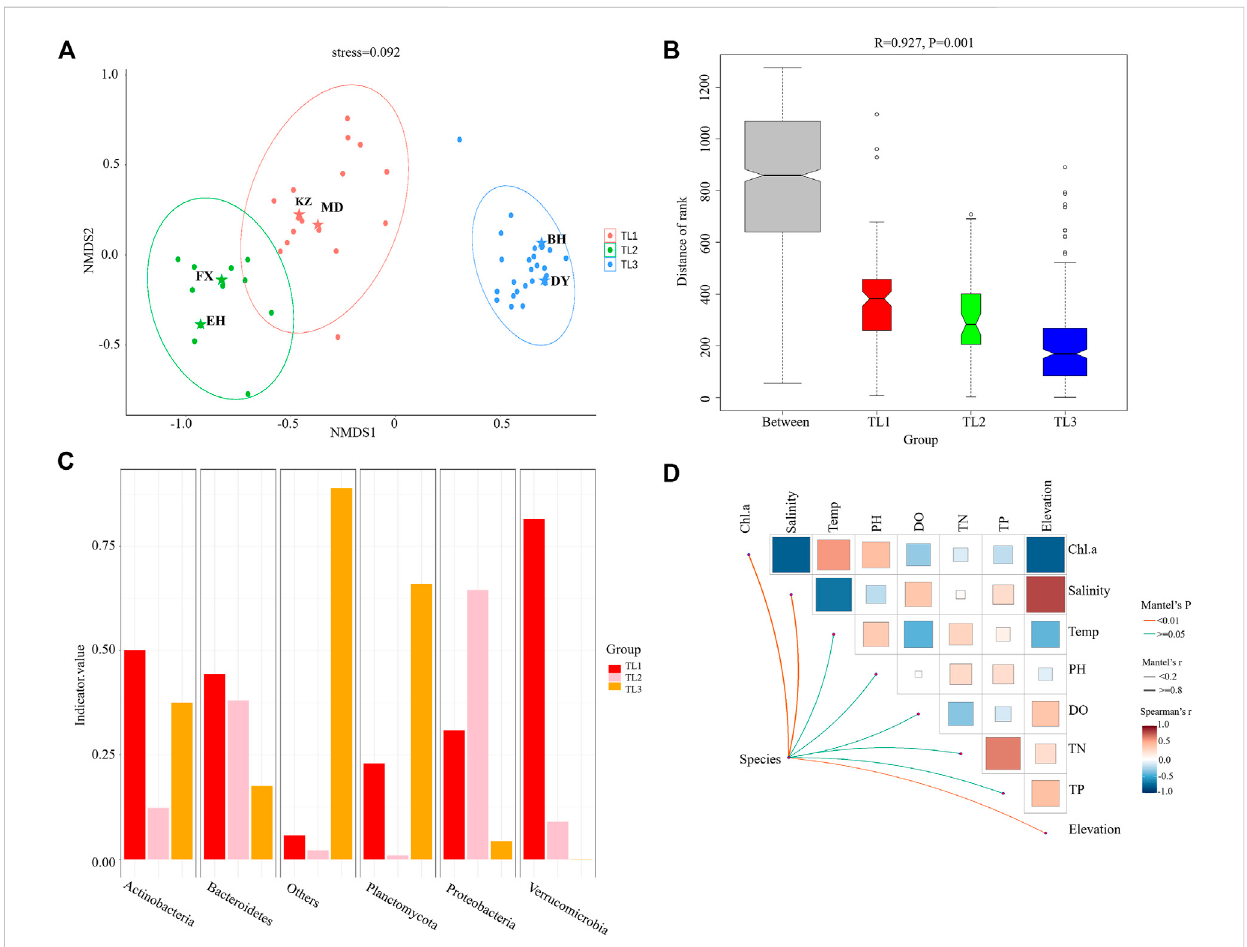
FIGURE 2 Microbial community diversity and its correlation with environmental drivers in surface water samples from 51 lakes. (A) Results of NMDS analysis of microbial composition based on Bray-Curtis similarities. The fi ve-pointed star site represents six typical lakes selected for sampling (Mandong Co (MD), Kunzhong Co (KZ), Erhai (EH), Fuxian Lake (FX), Bohu Lake (BH) and Daye Lake (DY)). (B) Box plots of the ANOSIM results on lake microbial community composition in individual terrain groups and between the groups; Borders represent interquartile range (IQR), whiskers represent the 1.5 times IQR range within the upper and lower quartiles respectively, points represent outliers that exceed 1.5 times IQR. (C) Indicator species analysis was used to reveal the species that cause signi fi cant differences between groups. The bars show the indicator values of the phyla in the groups. (D) Correlation analysis of environmental factors and microbial composition. Spearman correlation coef fi cient was used to measure the correlation between environmental factors, the color gradient and box size represent the degree of the correlation, red indicates positive correlation, and blue indicates negative correlation. Mantel test was used to measure the correlation between community composition and various environmental factors. Line width corresponds to Mantel ’ s r-statistic for distance correlations, line color denotes statistical signi fi cance based on 9,999